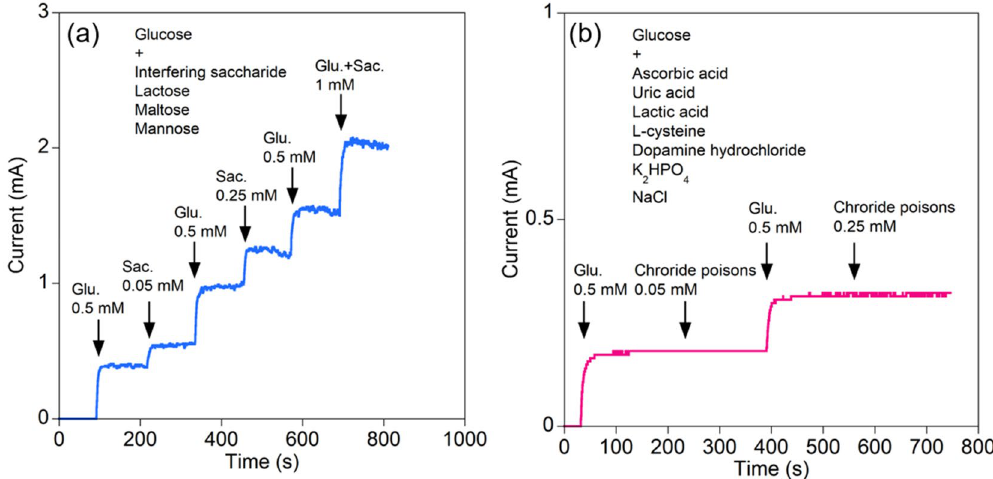
test of the sensor by subsequent mixing of 0.5 mM glucose and 0.25 mM of each interfering species and chloride poisons (ascorbic acid, uric acid, lactic acid, citric acid, L -cysteine, dopamine hydro- chloride, KH PO , and NaCl), and then again mixing 0.5 mM glu- 2 4 cose, followed by mixing 0.5 mM of interfering species and chlo- ride poisons in 0.1 M NaOH at an applied potential of 0.30 V (vs Ag/